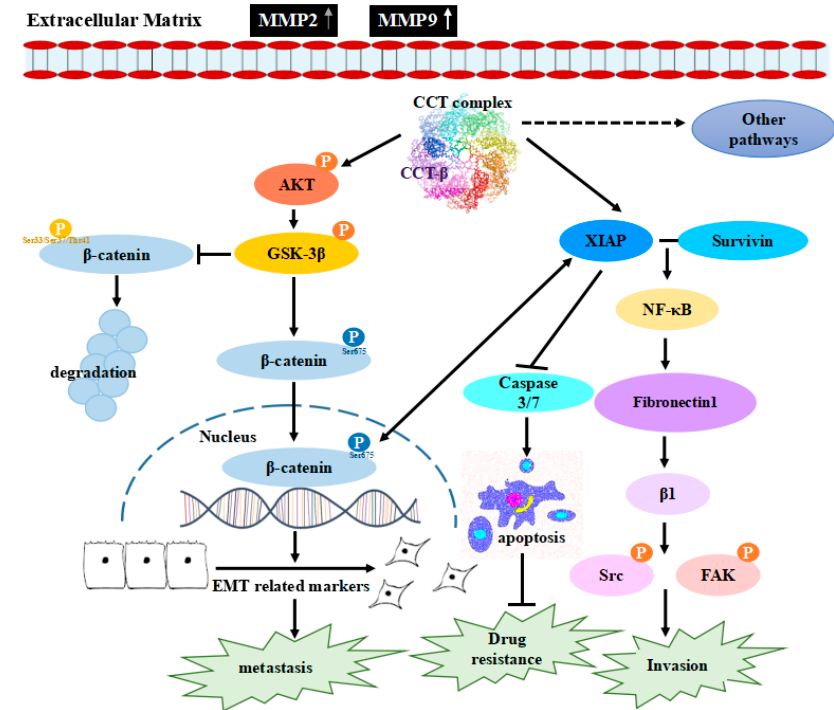
Figure 9. The molecular mechanism of CCT- β overexpression-induced chemoresistance, cell migration and invasion. CCT promotes the AKT-GSK3 β - β -catenin and XIAP-Survivin signaling pathways by directly interacting with β -catenin and XIAP, leading to increased drug resistance, cell migration and invasion.